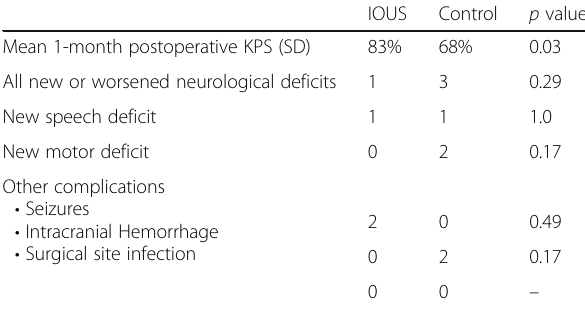
Table 4 Postoperative functional outcome and complications